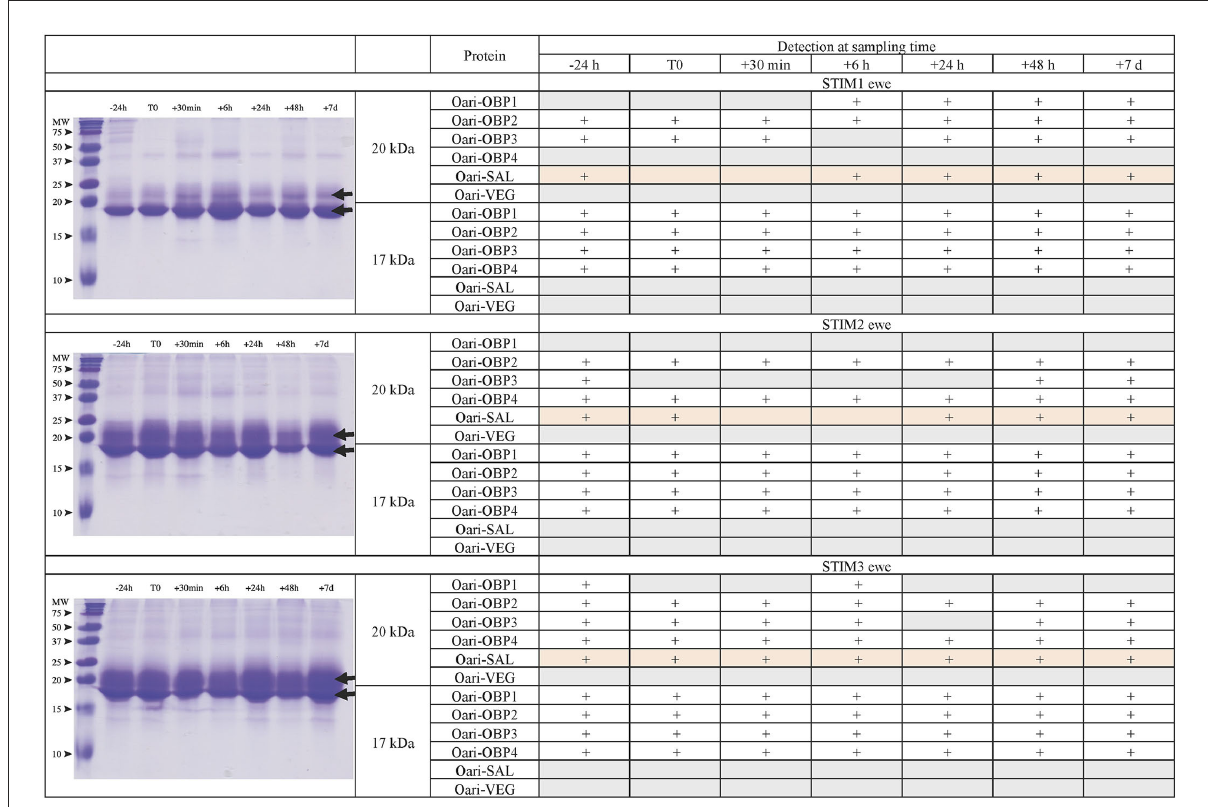
FIGURE1 Analysis of olfactory secretome of ewes exposed to the male. (Left) One-dimension separation (SDS-PAGE) of total soluble proteins extracted from nasal mucus at different sampling times. Coomassie blue staining. Molecular weight marker, Precision Plus Protein Standard Dual Color (Bio-Rad). Arrows indicate the 17 and 20 kDa migrating bands, the protein composition of which was determined by MALDI-TOF MS and is given in tables on the (Right)